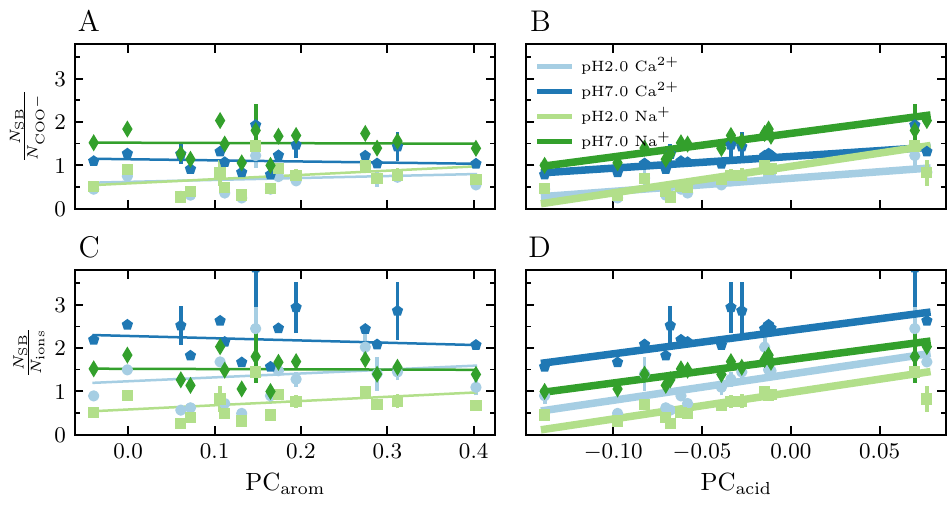
Figure 10. Number of salt bridges (N SB ) of the humic substances models as a function of their PC arom and PC acid . Number of salt bridges (N SB ) of the humic substances models normalized by the number of carboxyl groups (N COO − ) ( A , B ). Number of salt bridges (N SB ) of the humic substances models normalized by the number of ions (N ions ) ( C , D ). Each point represents the average over four independent simulations with error bars representing the standard